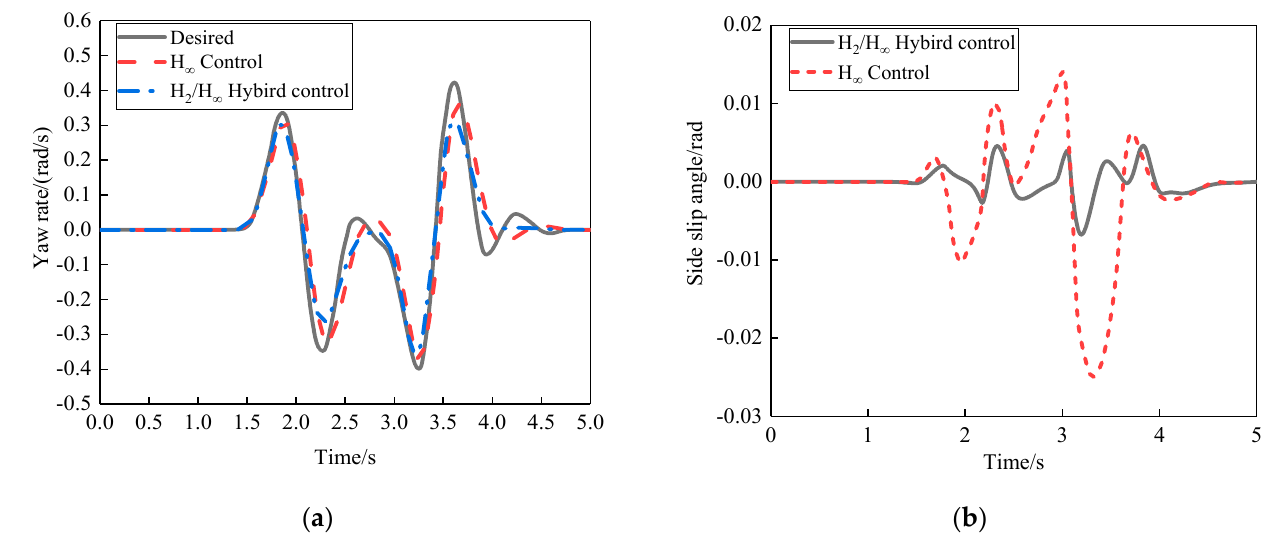
Figure 7. Double-lane change simulation condition verification: ( a ) yaw rate; ( b ) side slip angle. As it can be seen in Figure 7a, the AFS system can track the path well under both H ∞ control and H 2 /H ∞ mixed robust control. By comparison, the yaw velocity of H 2 /H ∞ hybrid robust control is closer to the reference curve than that of H 2 /H ∞ hybrid robust control, which indicates that the AFS system adjusts the weighting function of P 1 , and the yaw velocity of the vehicle can sufficiently track the ideal yaw velocity. This is because the working range of the tires with H 2 /H ∞ hybrid robust control is mainly concentrated in the linear region and seldom enters the nonlinear region. Figure 7b is the response graph of the side slip angle. According to the graph, the side slip angle of H 2 /H ∞ hybrid robust control is far less than that of H ∞ control, which further proves the effectiveness of H 2 /H ∞ hybrid robust